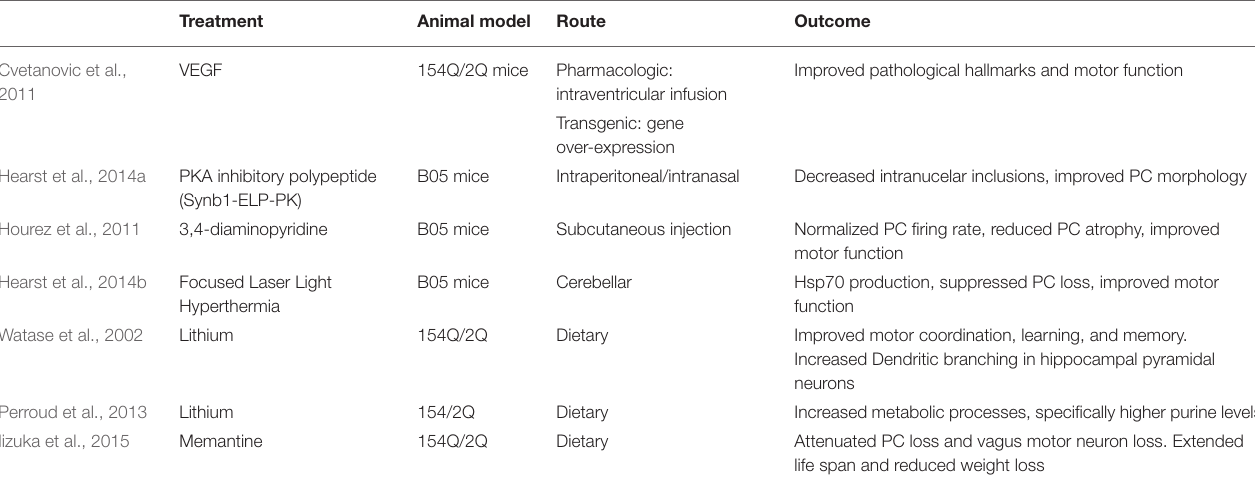
TABLE 5 | Overview of other therapies for SCA